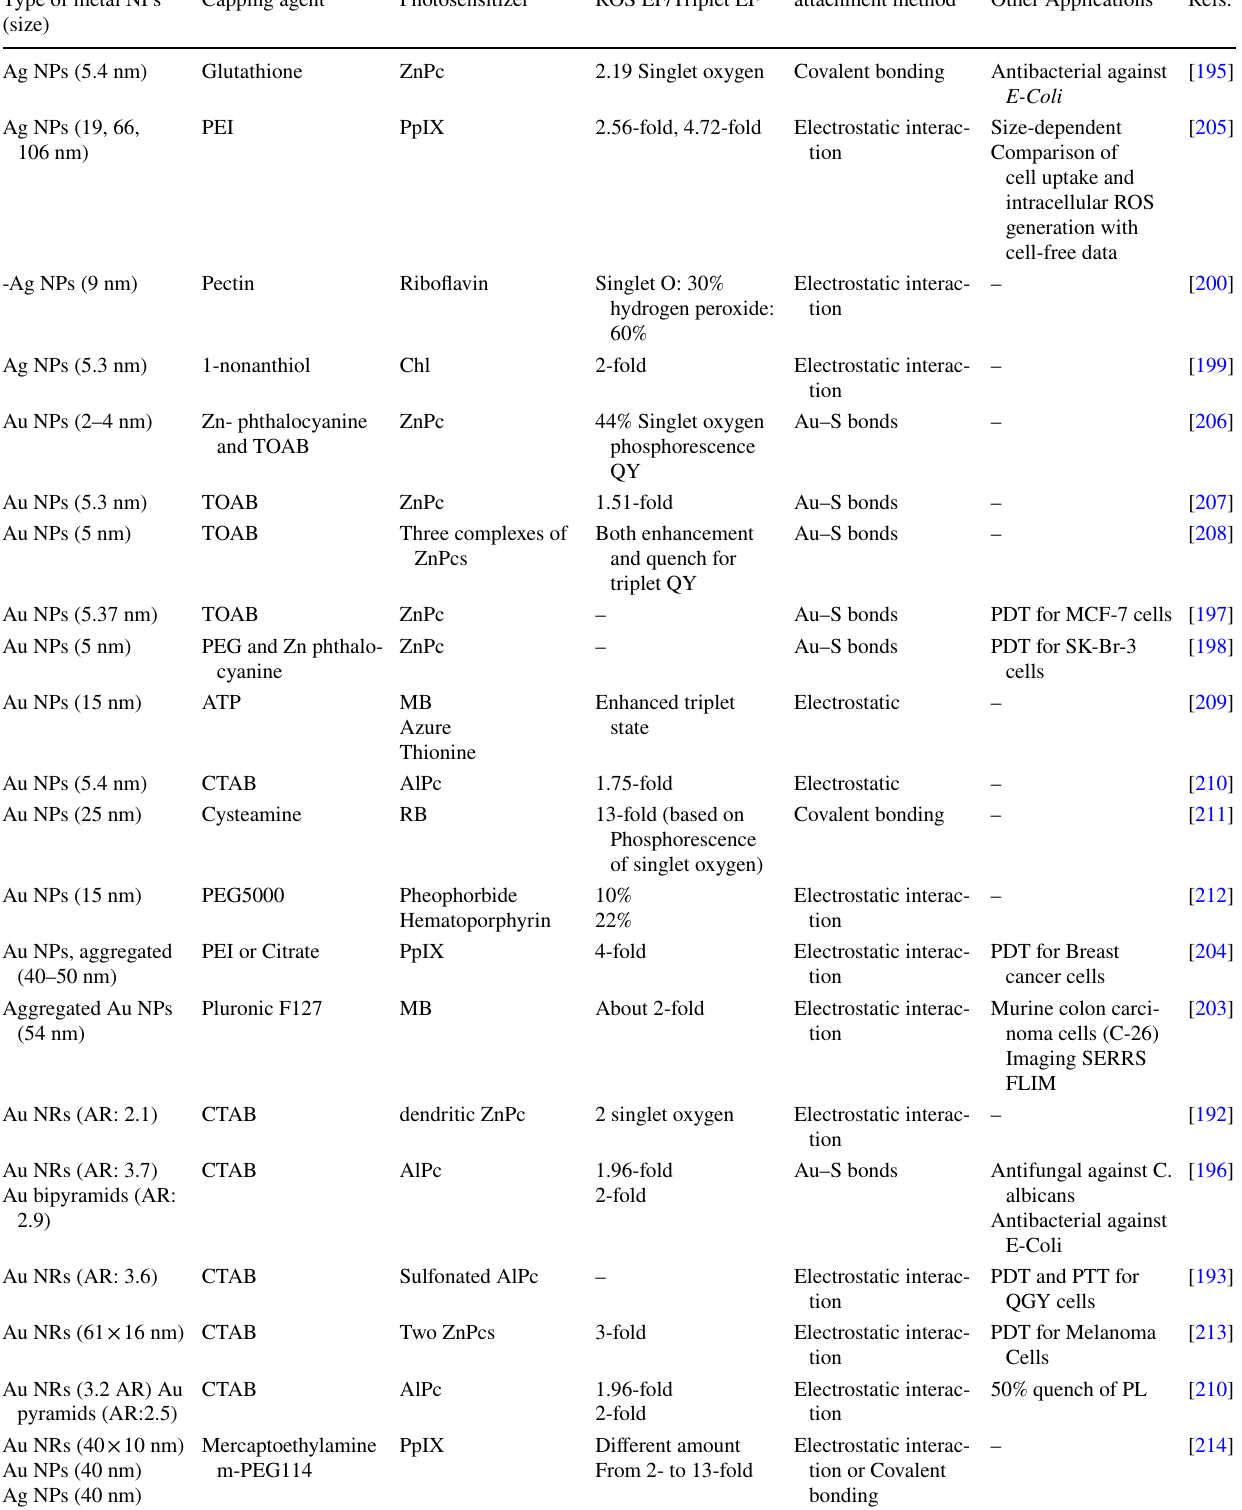
Table 2 Colloidal metal-photosensitizer systems without additional spacer Type of metal NPs